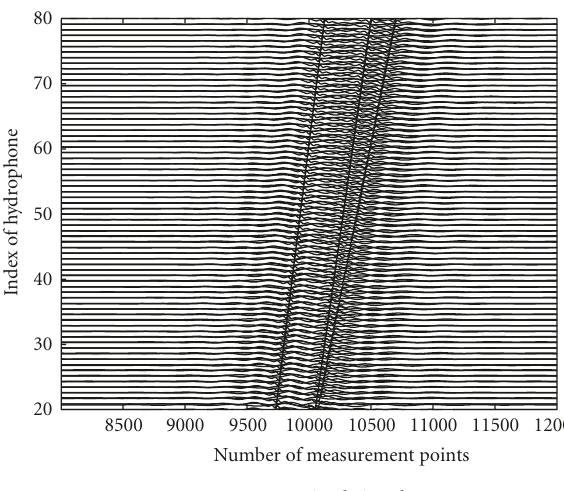
Figure 15: Received